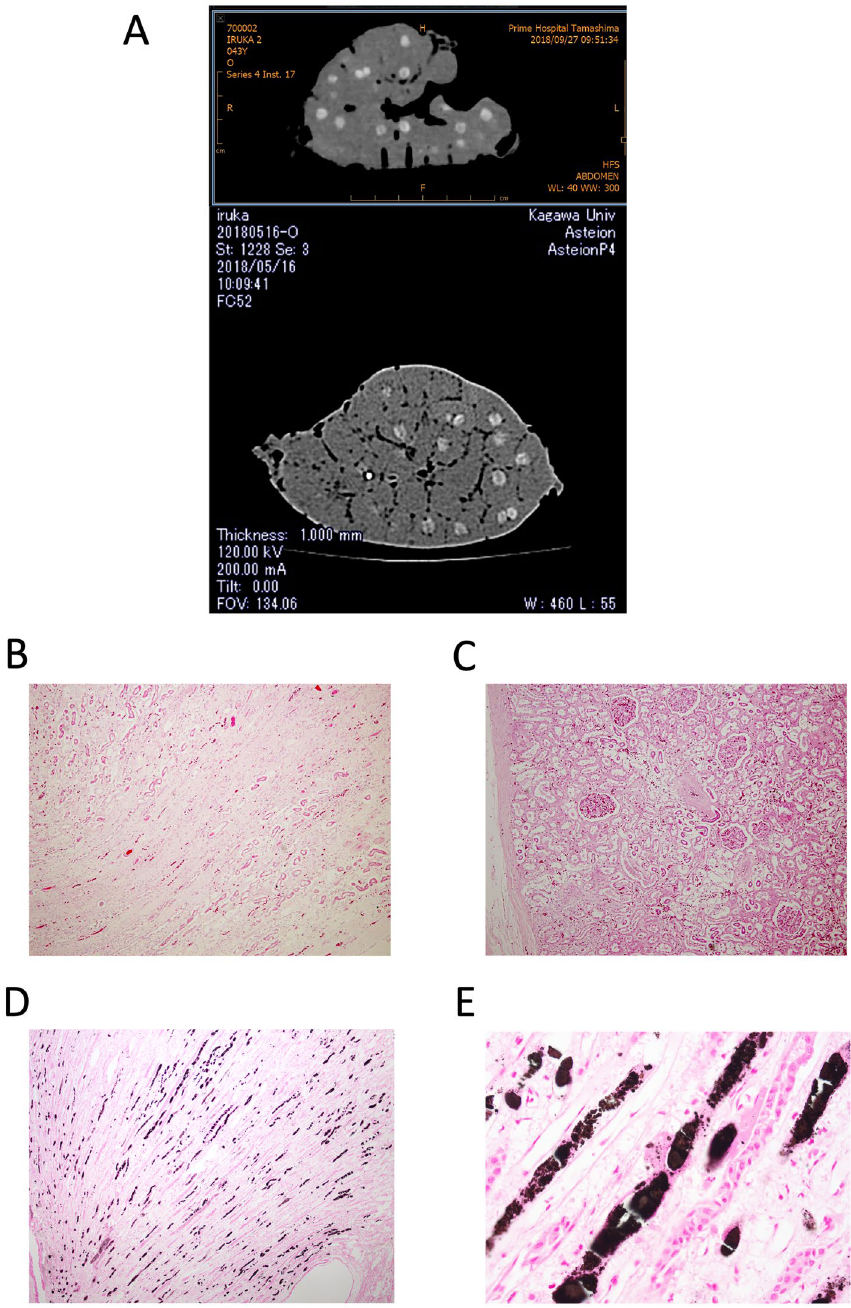
Figure 1. CT scan and histological findings in necropsy tissues in a dolphin. Representative CT image of the right kidney ( A ). A CT scan shows many high-density areas in the reniculi in the medullary portion of the kidney. Histology with HE staining ( B , C original magnification, × 40 and 100, respectively) and Von Kossa ( D , E original magnification, × 100 and 400, respectively) staining, respectively. There is no obvious abnormality in the renal tissues or vessels except infarcted area, but minor glomerular sclerosis and interstitial fibrosis can be seen. Von Kossa staining is positive in part of the medullary region. CT computed tomography, HE hematoxylin and